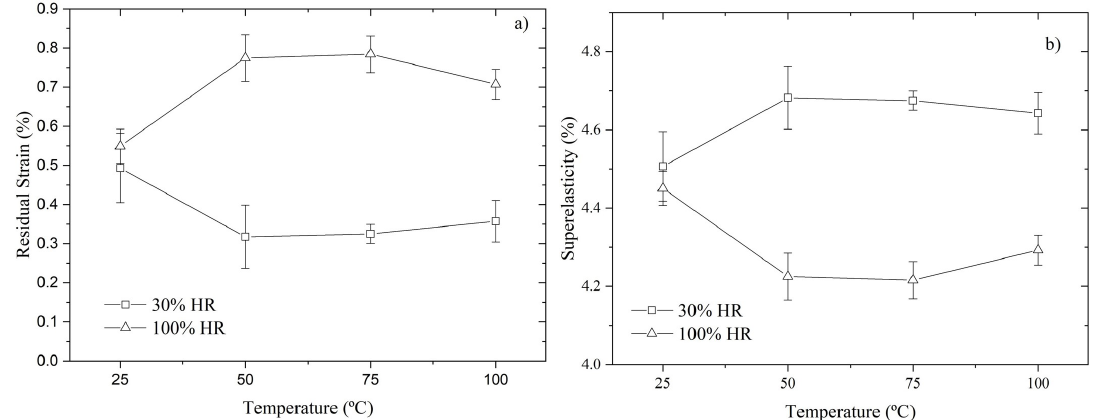
Figure 7 - a) Residual strain as a function of lamination degree and temperature. (b) Superelasticity as a function of lamination degree and